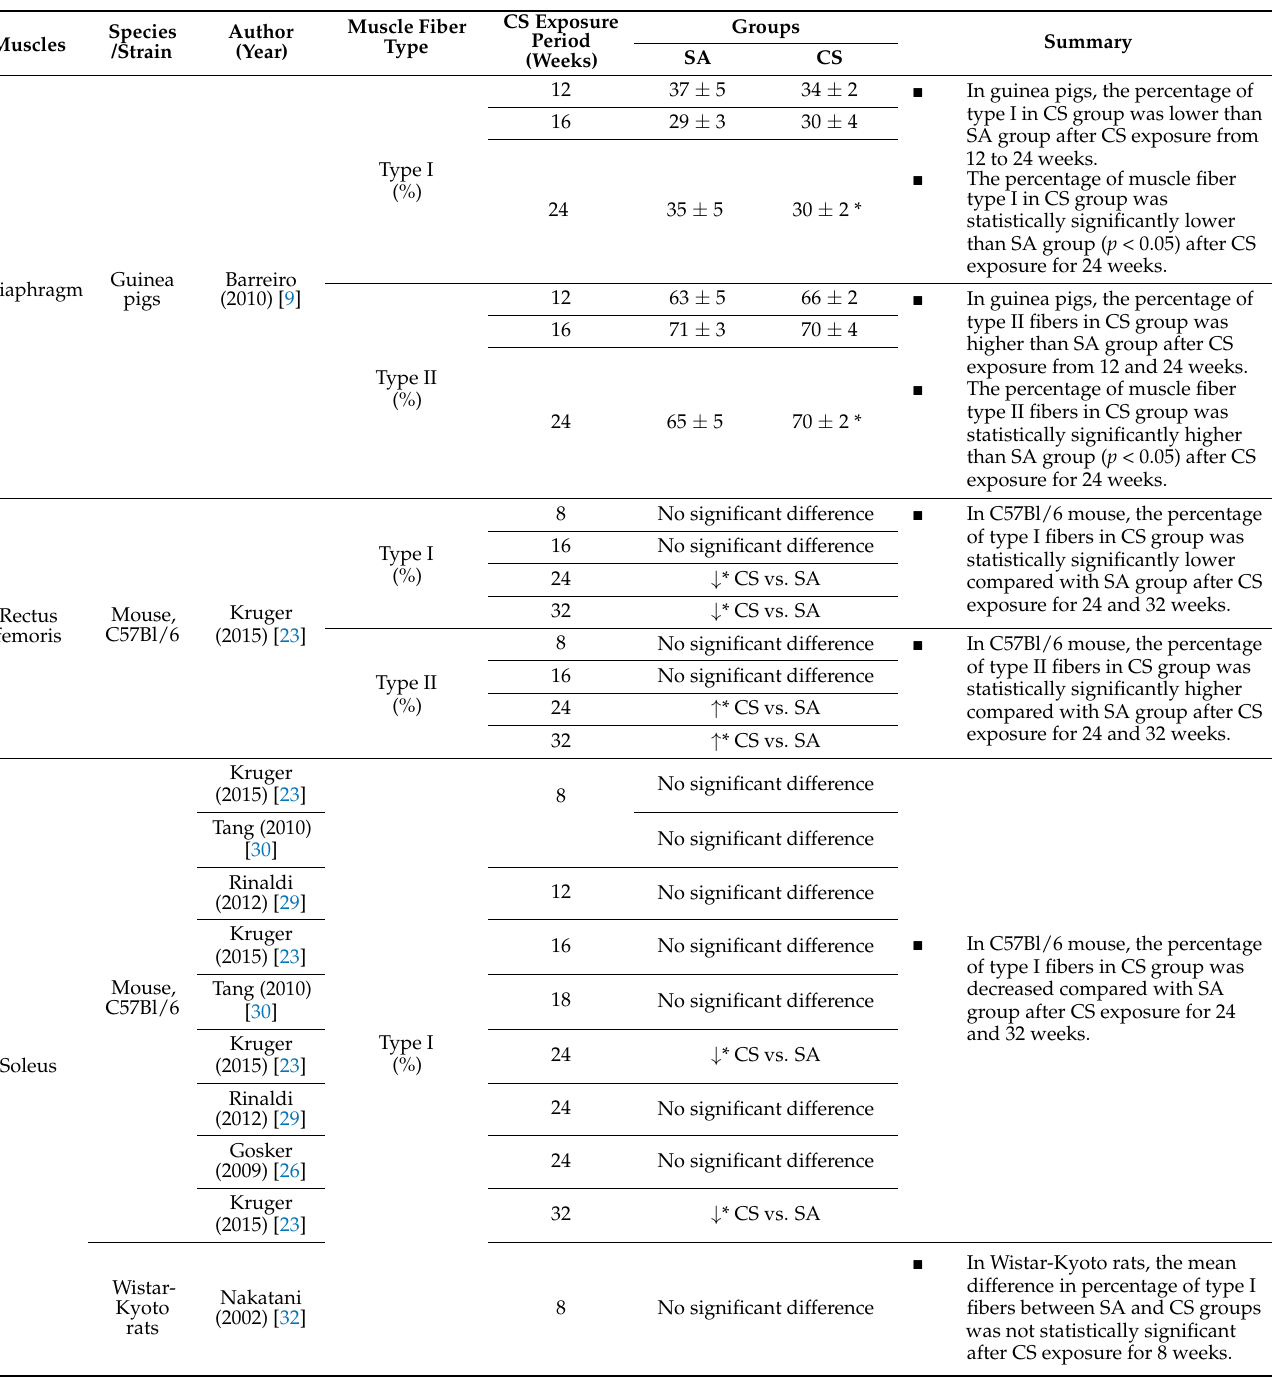
Table 4. Percentage of muscle fiber types at different time points during CS